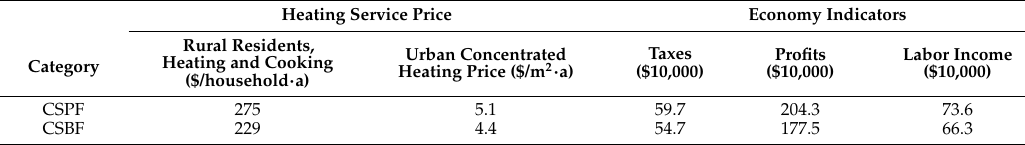
Table 9. Cost of heating service and economic indicators of a CSDF-DHS in the